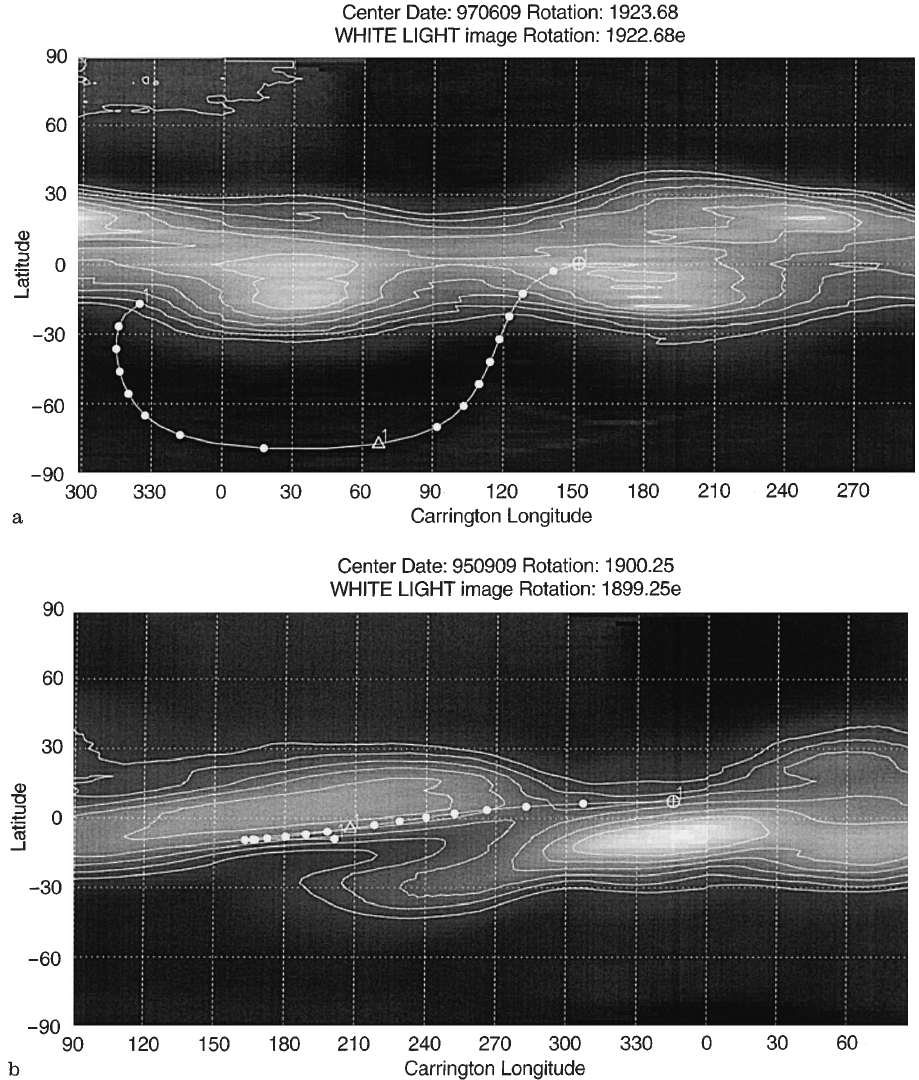
Fig. 1. a Map of white-light in- tensity at 1.7 R , calculated from HAO Mk.3 coronagraph mea- surements centred on 9 June 1997. Line 1 represents the IPS ray-path for measurements of the radio source 0521+166 on 9 June 1997, projected down to 1.7 R with an assumed velocity of 750 km s ) 1 . The triangle marks the closest approach of the ray-path to the Sun and the crossed circle denotes the position of the Earth. Almost all of the ray-path lies above the southern polar coronal hole. b Map of white-light intensity at 1.7 R centred on 9 September 1995. Line 1 represents the IPS ray-path for measurements of the radio source 1150-003 on 9 September 1995, projected down to 1.7 R with an assumed velocity of 325 km s ) 1 . The whole of the ray- path lies above the bright equato-